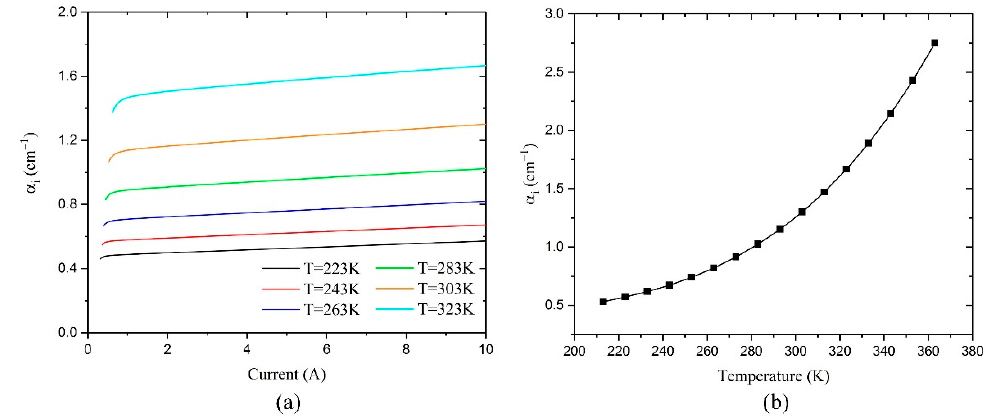
Figure 8. Temperature effects on internal optical loss ( a ) internal optical loss vs. injection current at different temperatures, ( b ) internal optical loss vs. temperature at an injection current of 10 A.